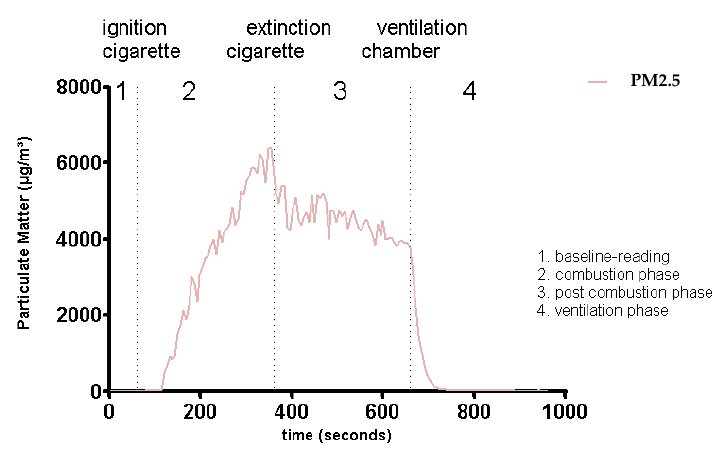
Figure 4. An example of a complete measuring cycle. Extinction not exctinction.